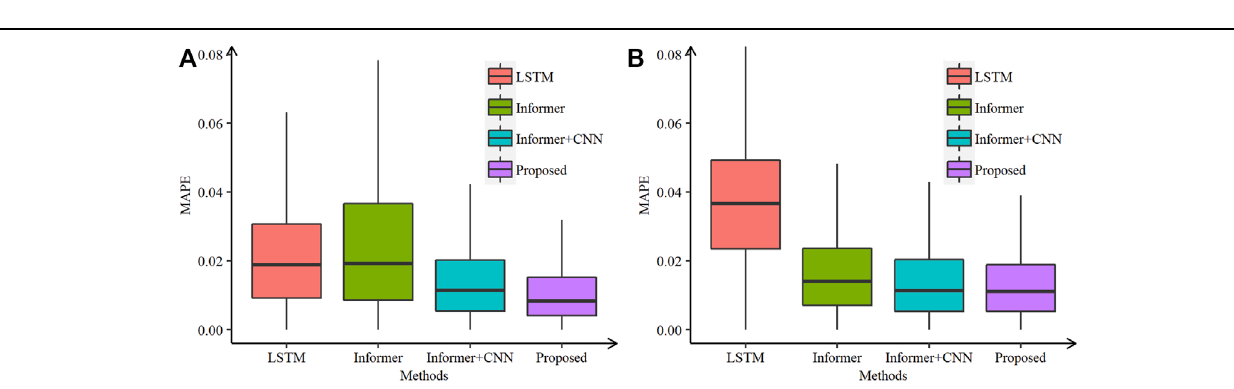
FIGURE 3 | Comparative box plots of the proposed and other models in the NA data set using (A) real and (B) noisy temperatures.